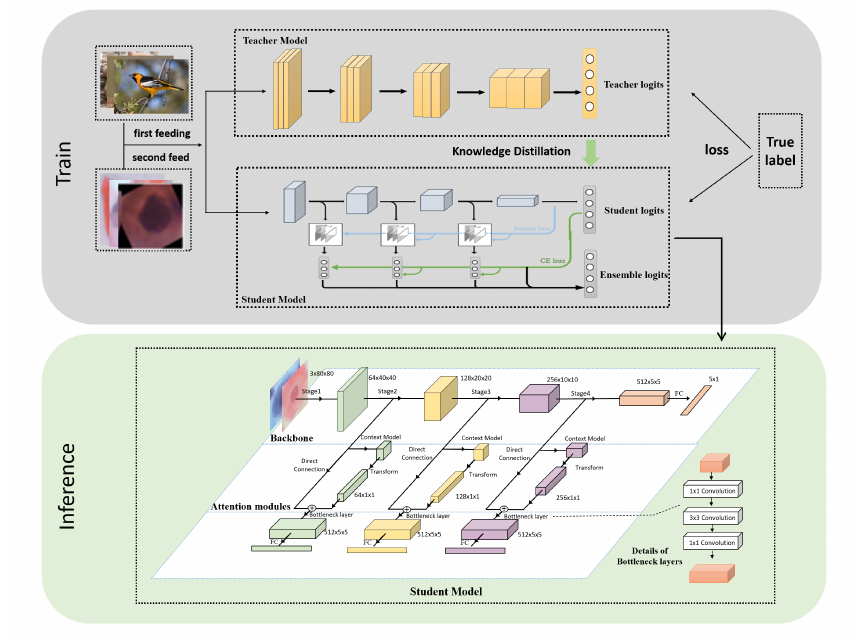
Figure 2. Overview of the proposed knowledge distillation-based method for cervical cell classifi- cation. The whole framework is divided into two parts: training and inference. The training part consists of: (i) pre-training the teacher and student networks first; (ii) fine-tuning using cervical cell images; (iii) the student network adding a bottleneck layer and a fully connected layer after each block to build a multi-exit network from shallow to deep, and (iv) in the inference stage, each classifier being combined in an ensemble to form a strong